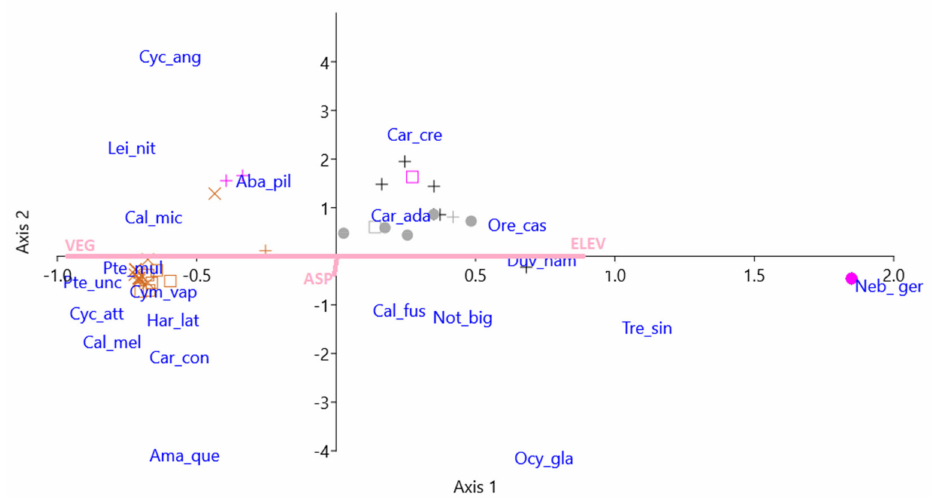
Figure 4. CCA triplot of the distribution of carabid species in relation to the altitude (Alt), vegetation cover (Veg) and aspect (Asp) (vectors in pink). Nature 2000 habitat types are represented as follows: 8210-8240 = black dot; 8120 = plus; 6170 = square; 4070-9420 = X. Landform types are represented as follows: bedrock = dark gray; large rockslide deposit = black; talus slope = fuchsia; mature slope = light brown. Species abbreviation refers to Table